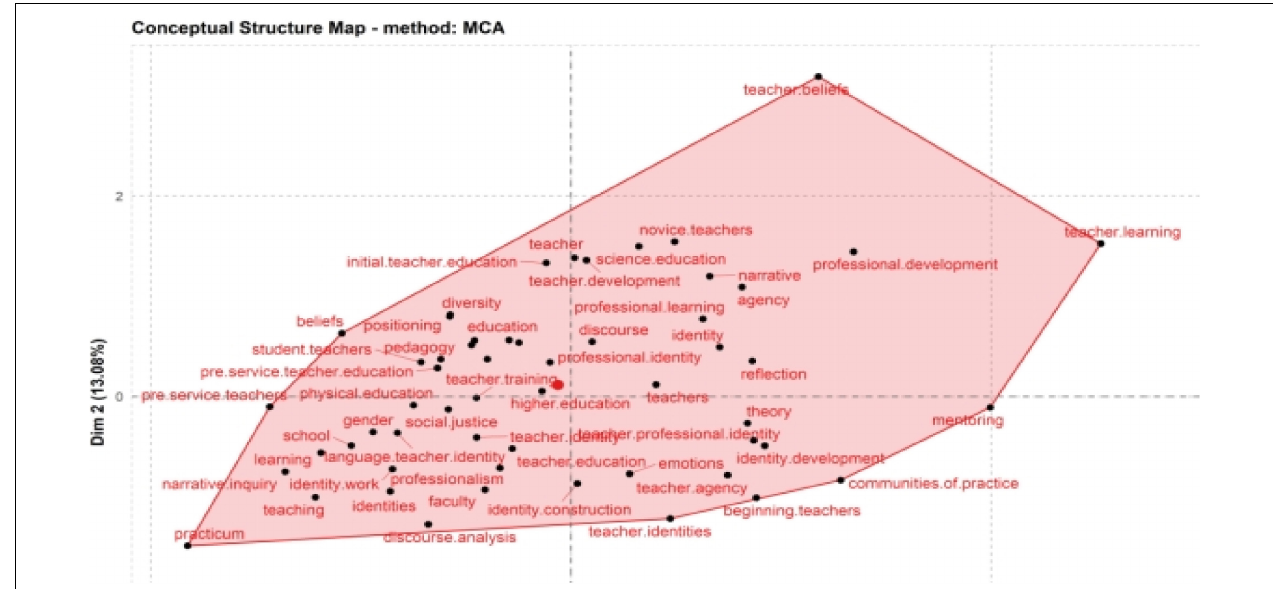
FIGURE 9 | Conceptual structure